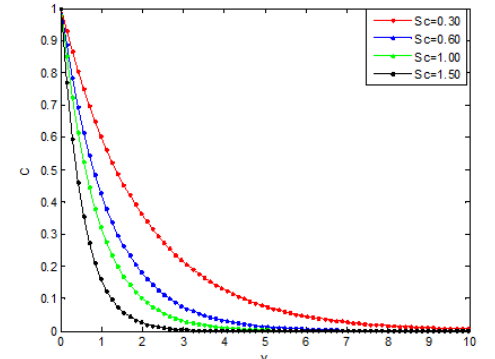
Figure 15. Effects of Schmidt number on the concentration distribution